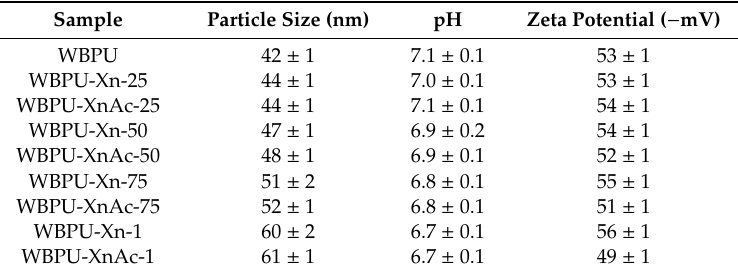
Table 2. WBPU dispersion properties.